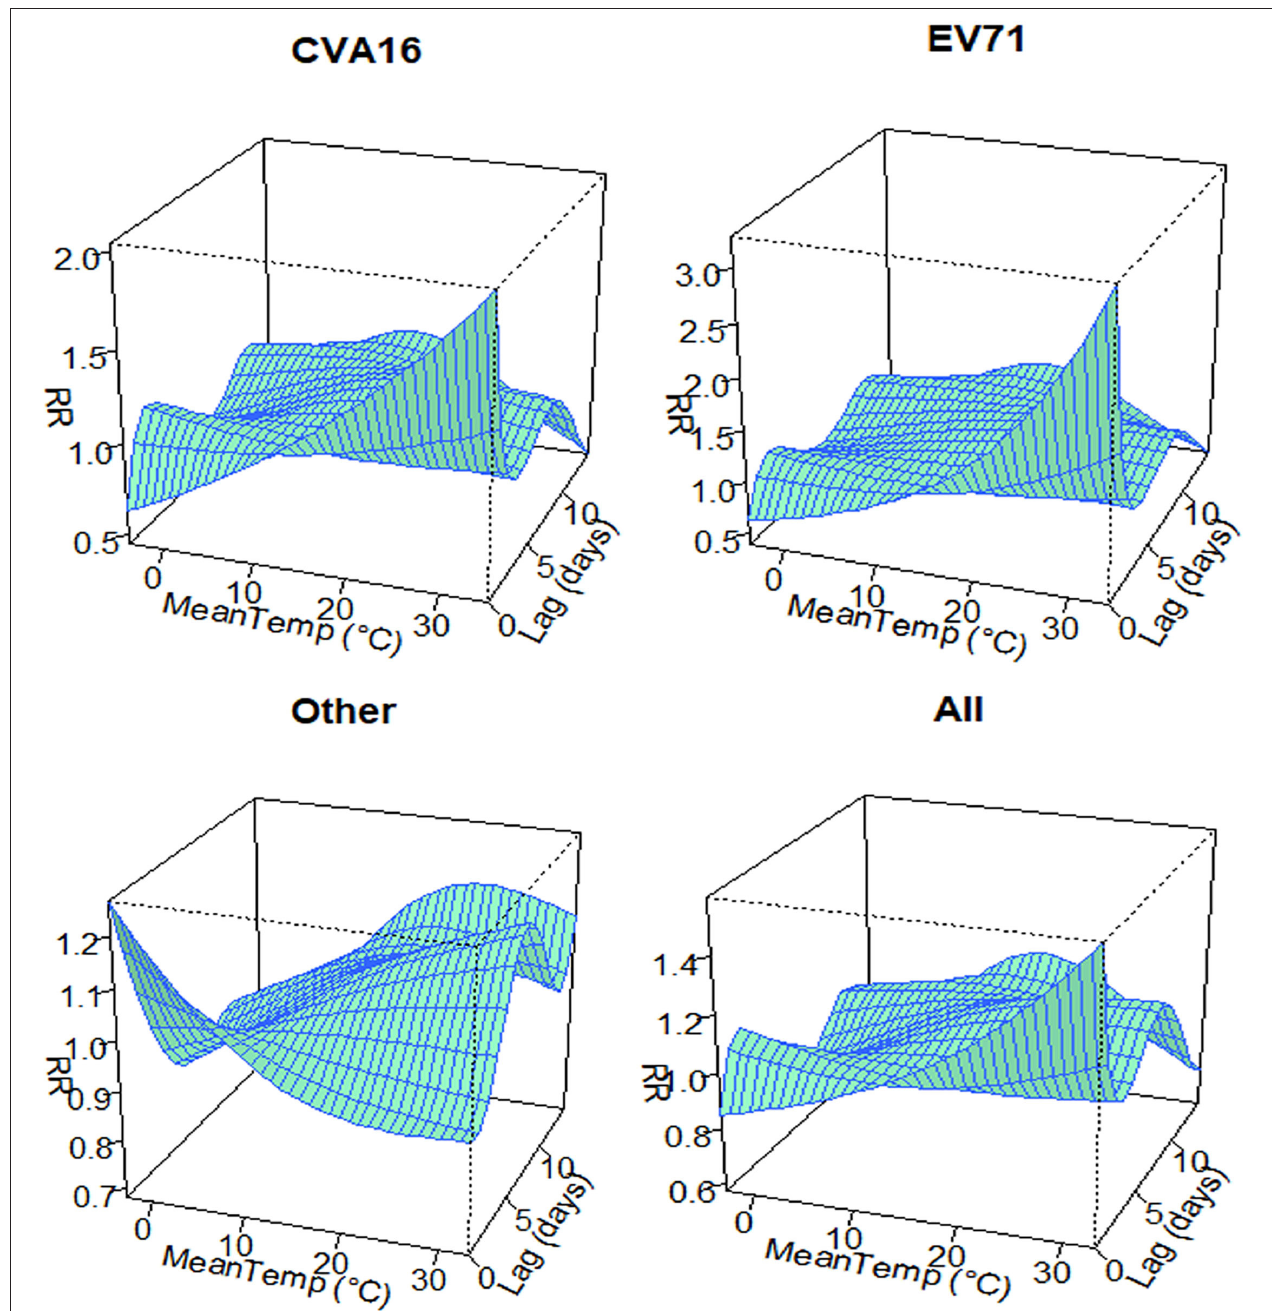
FIGURE 6 | Relative risks of daily HFMD by daily mean temperature along 14 lag days in Zhejiang province, China from 2010 to